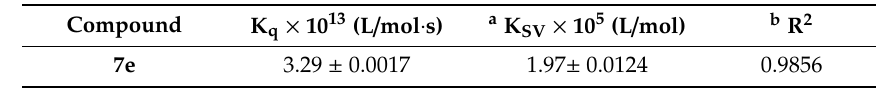
Figure 4. The Stern–Volmer curves for the quenching of BSA (1.5 µ M) by 7e (0.3 µ M; 0.6 µ M; 0.9 µ M; 1.2 µ M; 1.5 µ M 1.8 µ M) ( λ ex = 289 nm, T = 298K). Table 6. Stern–Volmer equation constants for the interaction of BSA with the compound 7e at room temperature ( λ max BSA = 341